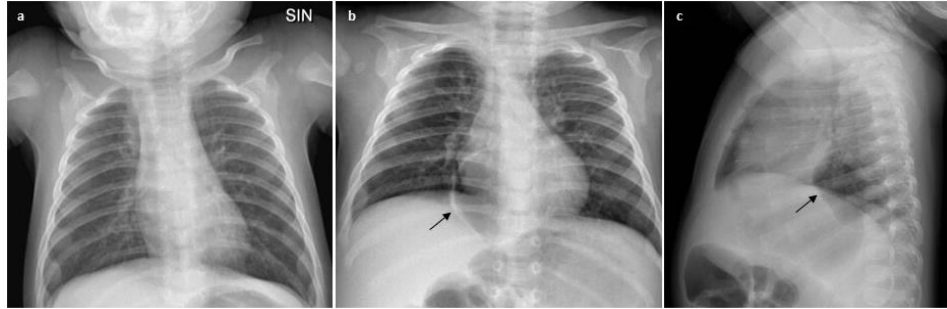
Figure 1. Chest X-ray changes: before ( a ) and after ( b , c ) ventilatory support with HelmetCPAP; the oval-shaped lesion is indicated by the black arrow.